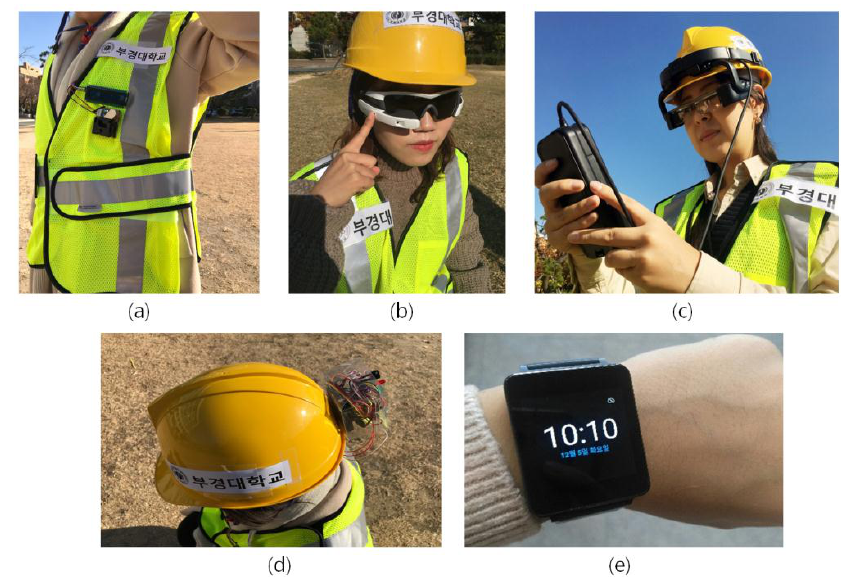
Figure 5. Proposed embedded wearable system shown at a mining site: ( a ) sensor-equipped mine safety vest; ( b ) miner wearing Recon Jet Smart Eyewear; ( c ) miner using Epson Moverio BT-2200; ( d ) sensor-equipped safety helmet; ( e ) smartwatch.